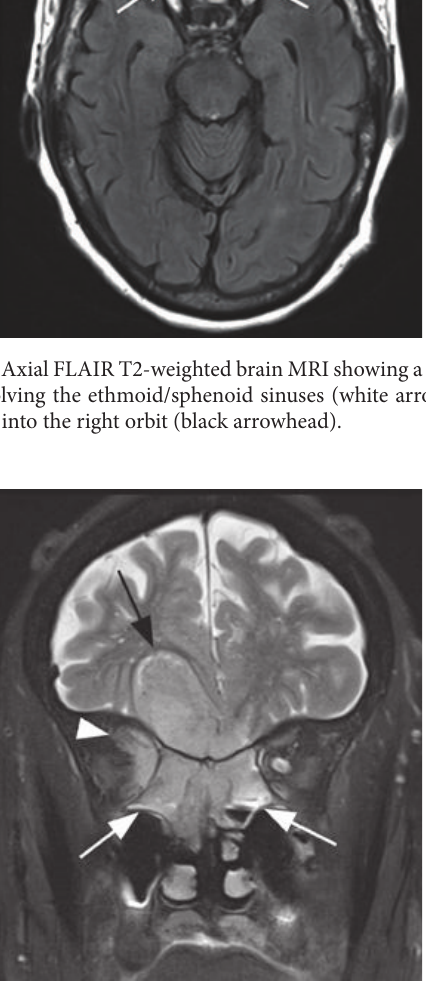
Figure 3: Coronal T2-weighted brain MRI showing a sinonasal mass involving the ethmoid/sphenoid sinuses (white arrows) with extensionintotherightorbit(whitearrowhead)andanteriorcranial fossa (black